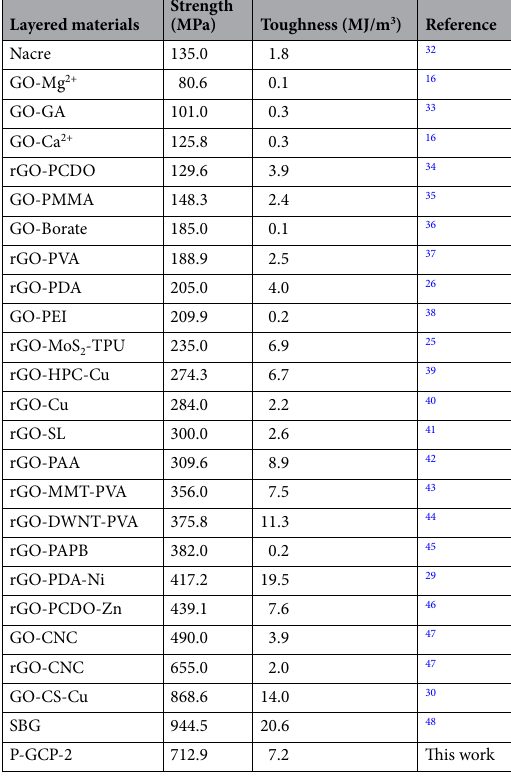
Table 6. Mechanical properties of natural nacre, P-GCP-2 ternary artificial nacre, and other GO-based layered materials.